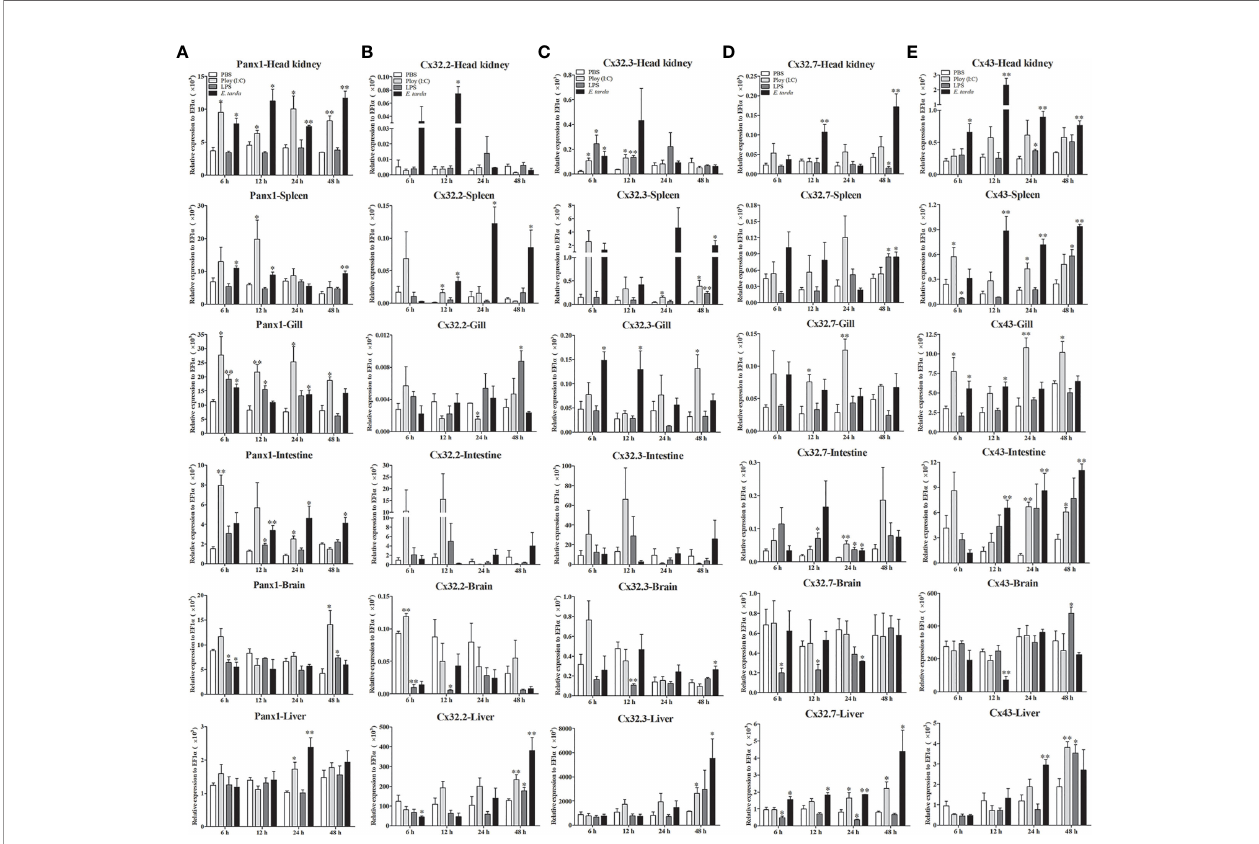
FIGURE 6 | Expression of Lm Panx1 (A) , Lm Cx32.2 (B) , Lm Cx32.3 (C) , Lm Cx32.7 (D) , and Lm Cx43 (E) after LPS, poly(I:C), or Edwardsiella tarda challenge. Spotted sea bass was i.p. injected with LPS (5 mg/kg body weight), poly(I:C) (5 mg/kg body weight), E. tarda (5 × 10 4 CFU/ fi sh), or PBS (control) The relative expression levels of target genes were normalized to that of EF1 a . Data are shown as mean +SEM (N = 4). * p < 0.05, ** p < 0.01 are considered signi fi cant